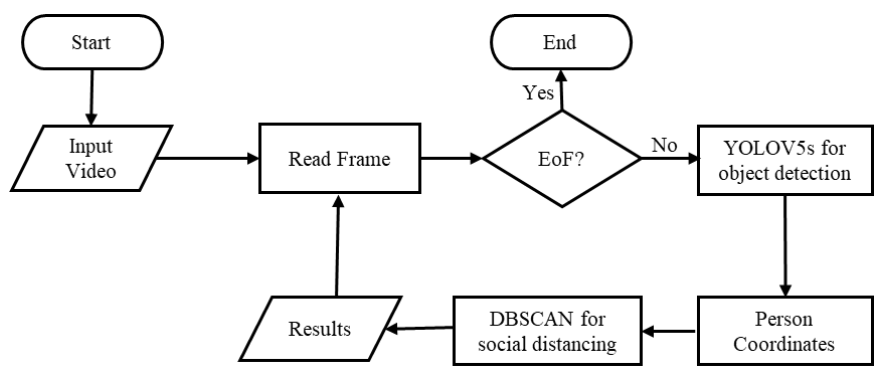
Figure 3. Proposed flowchart for face mask and distance